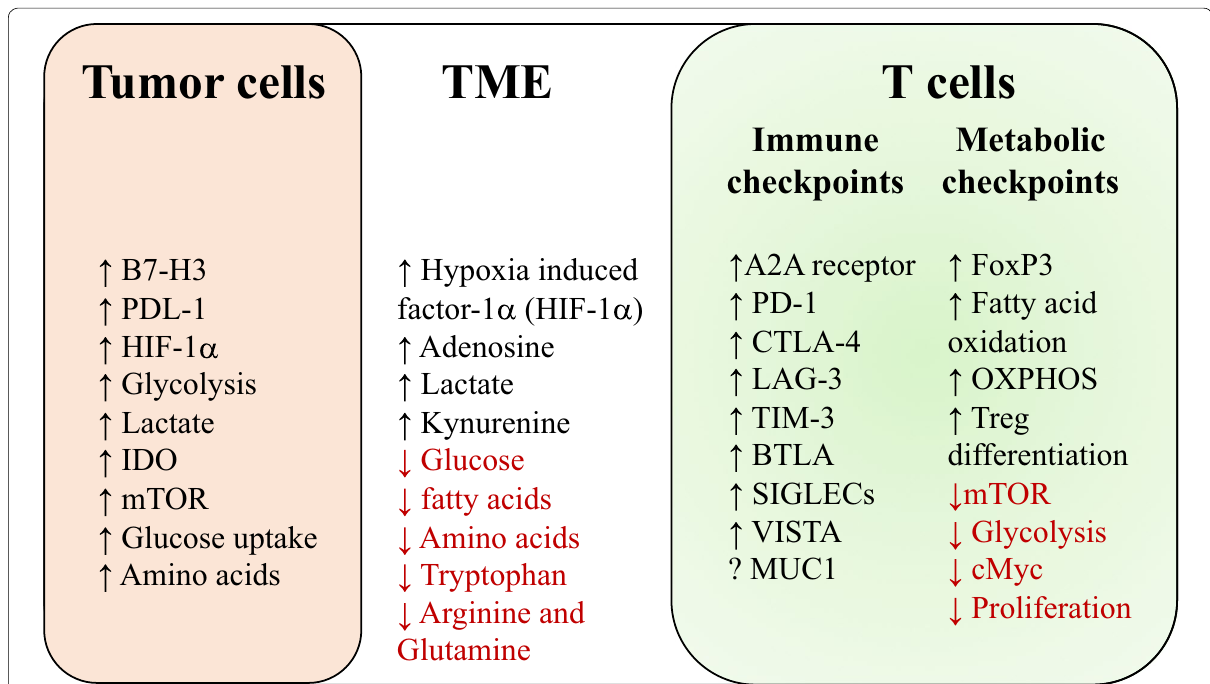
Fig. 2 Immune-metabolism in the tumor microenvironment (TME). Fast growing tumor cells, under hypoxic conditions, lead to upregulation of HIF-1α, enhanced consumption of nutrients, increased glycolysis and increased production of adenosine and lactate, all of which in turn produce a microenvironment rich in adenosine, lactate and HIF-1α, but with a scarcity of nutrients for tumor-infiltrating immune cells. This metabolic microenvironment programs the immune cells such that (1) anergic T cells, with inefficient proliferation and effector function, as well as (2) regulatory T cells, are predominant in TME. Furthermore, T cells with increased expression of a number of immune checkpoints and loss of effector functions, a hallmark or exhausted T cells, are characteristics of TME. This figure depicts T cells as an example immune cell type for clarity, but as described in the manuscript text, other lymphoid and myeloid cells are also present in the TME and are intensively involved in tumor